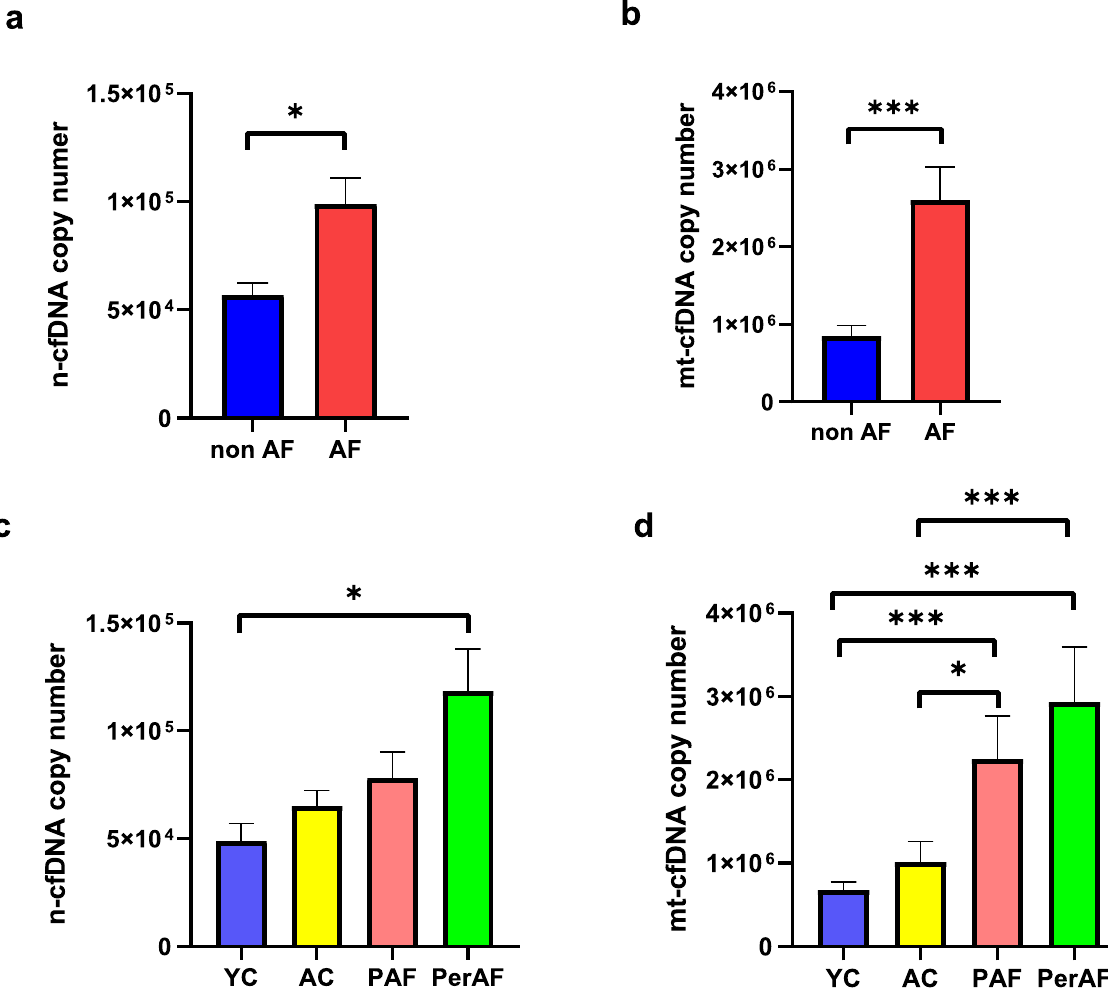
Figure 2. mt-cfDNA, rather than n-cfDNA, was increased in AF patients. Comparison between non-AF and AF for n-cfDNA ( a ) and mt-cfDNA ( b ). Comparison among the 4 subgroups for n-cfDNA ( c ) and m-cfDNA